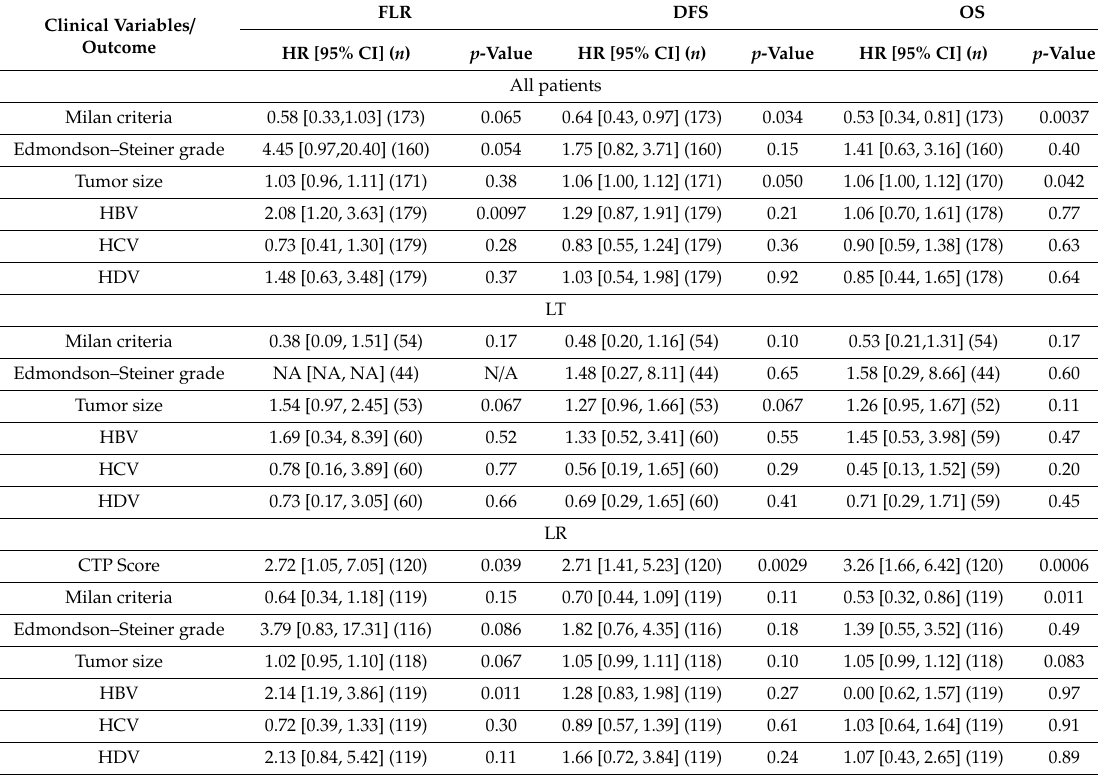
Table 3. Association between background clinical variables and freedom of liver recurrence (FLR), disease-free survival (DFS) and overall survival (OS) in hepatocellular carcinoma patients who underwent surgical treatments. p -Value from Wald test in a univariable Cox regression using log-transformed